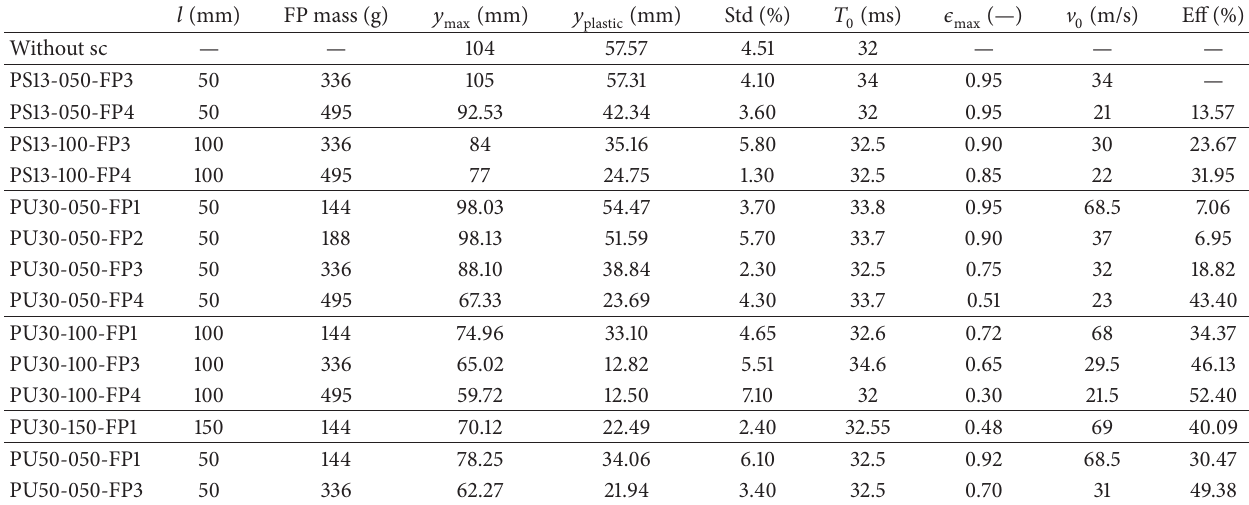
Table 4: Experimental results for the investigated sacrificial cladding configurations.